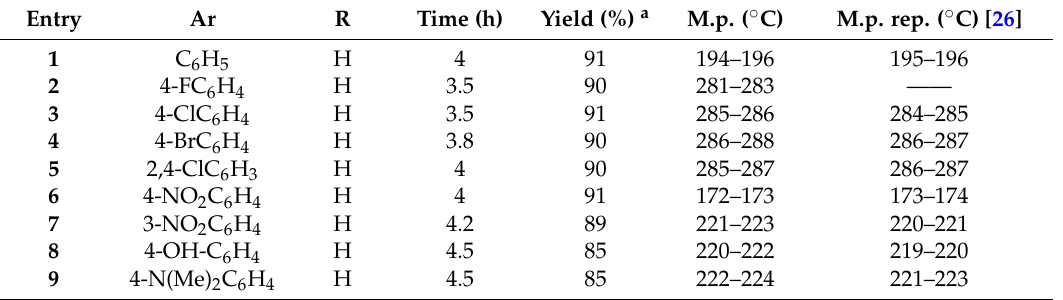
Table 3. One pot, five-component synthesis of pyrazolo-[4 1 ,3 1 :5,6]pyrido[2,3- d ]pyrimidine-diones in refluxing water using a catalytic amount of